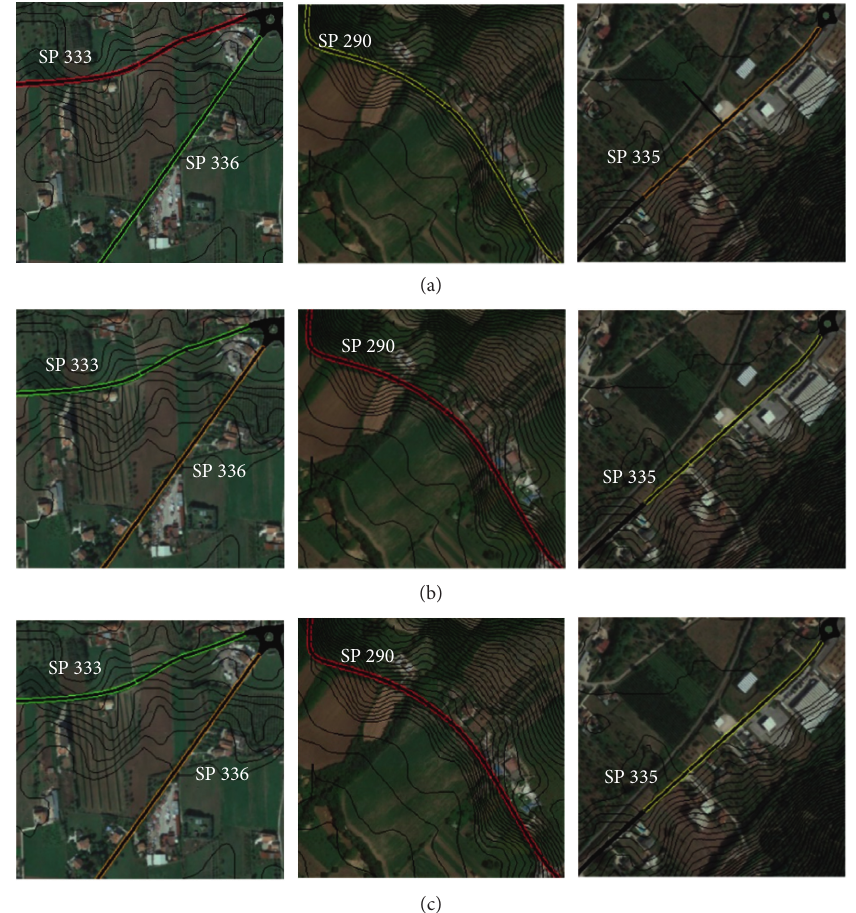
Figure 17: Dynamo algorithm output as displayed in Revit. (a) Year 2011. (b) Year 2012. (c) Year